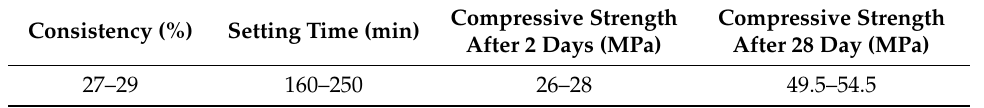
Table 4. Technical properties for cement PC 20M (S-L)